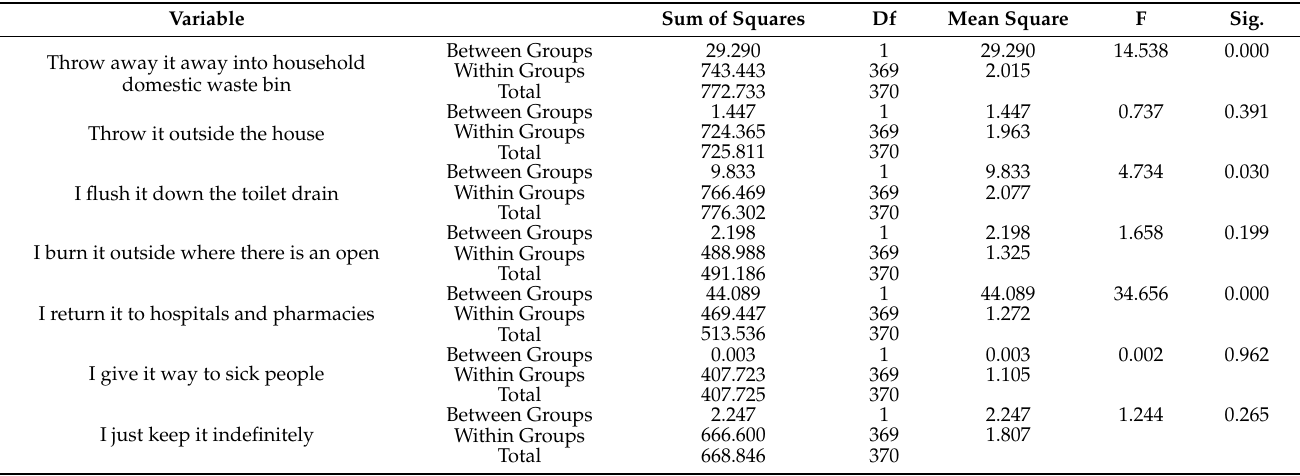
Table 9. The results of the ANOVA regarding perceptions of respondents in terms of waste disposal practices. Df = degree of freedom; F = F value; Sig. = significance (p